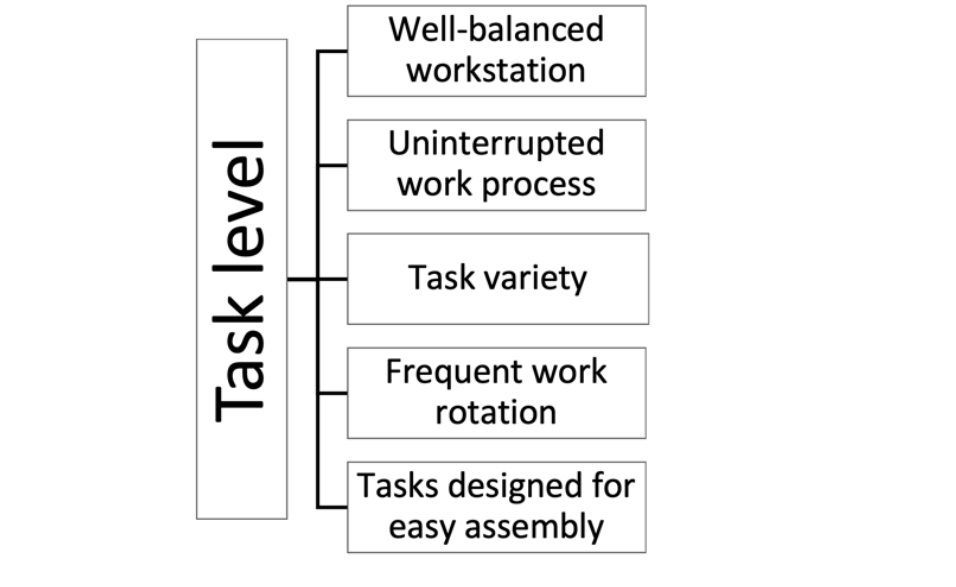
Figure 7. Resources at the task level.